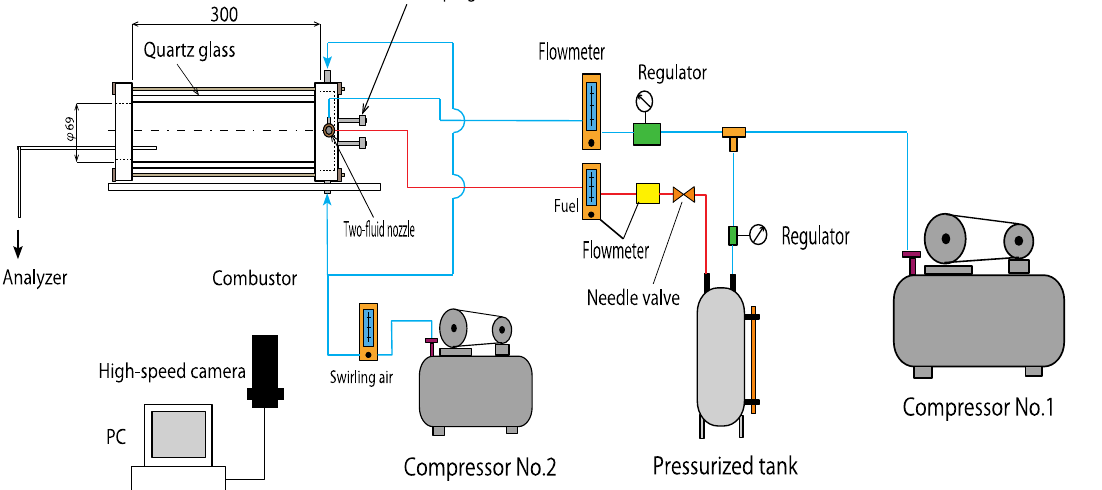
Figure 4. Experimental apparatus.